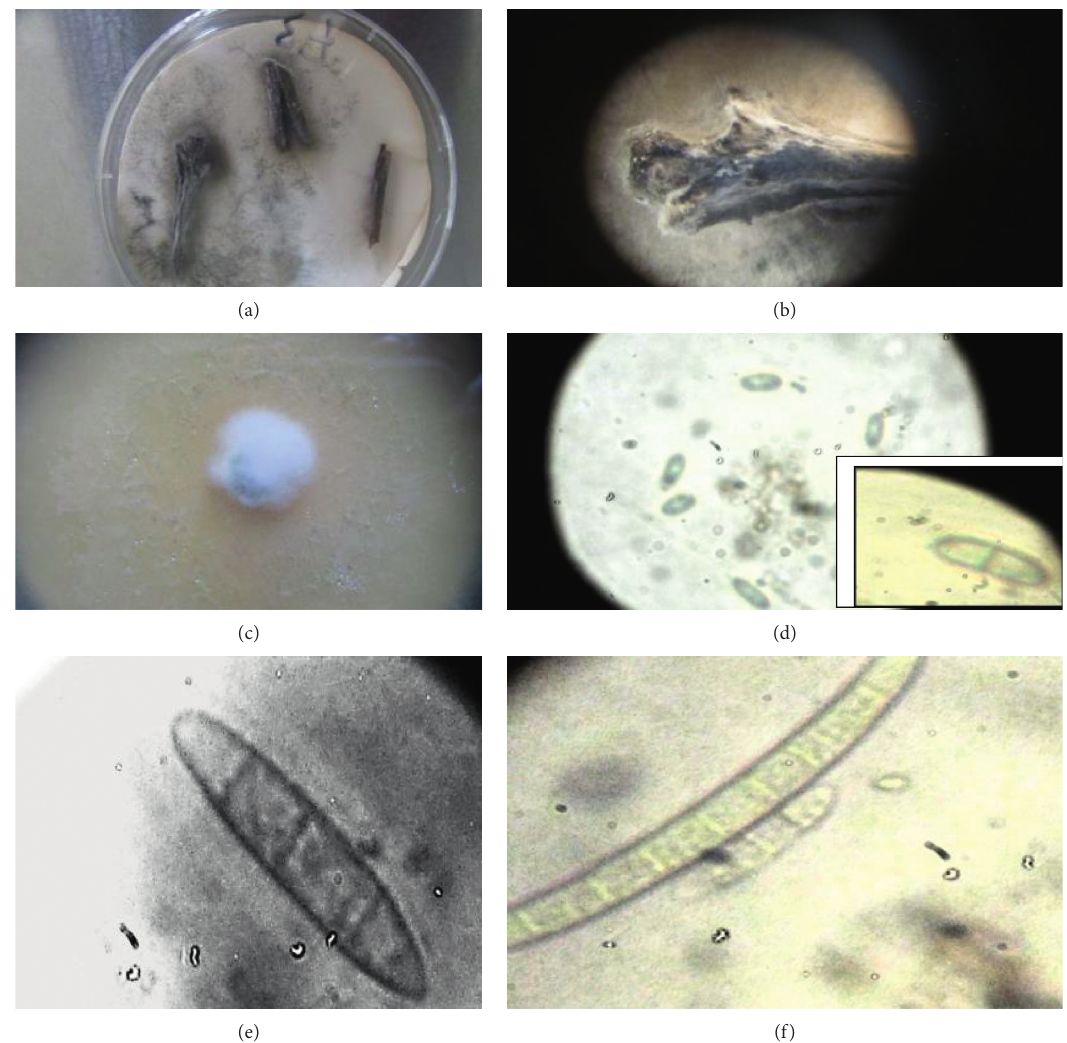
Figure 4: Characteristics of Fusarium oxysporum from soil and plant samples. Sparse to abundant growth of white mycelium covering part of the plant (a, b) and soil (c) samples; microconidia (d) and macroconidia (e and f) under wet